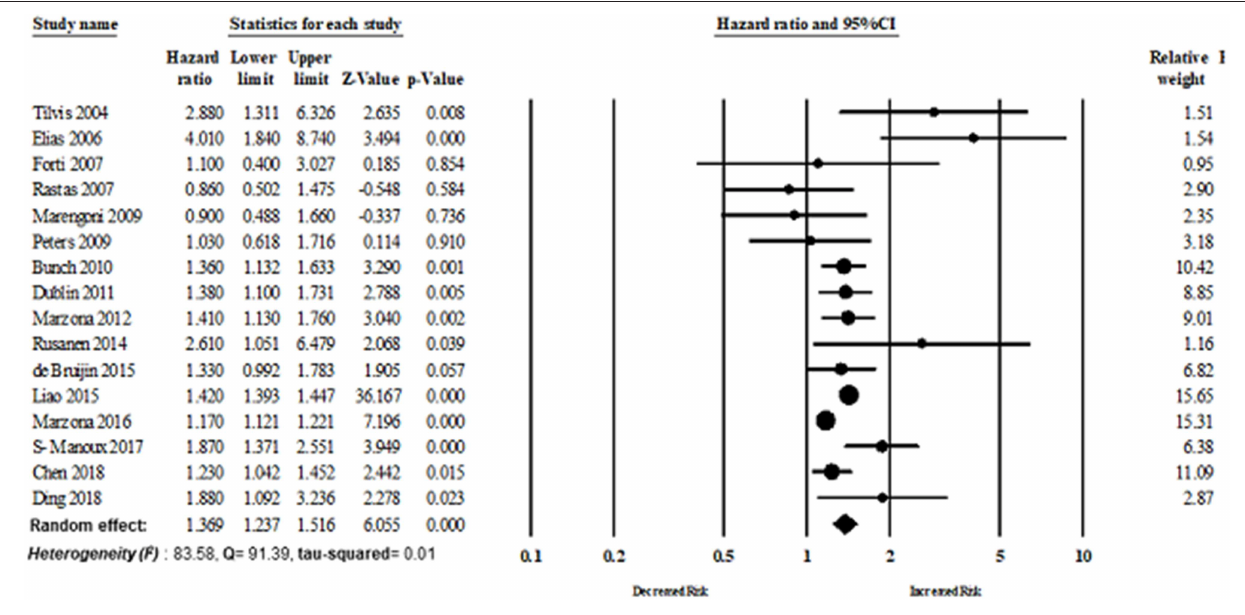
FIGURE 3 | Association between AF and dementia risk.